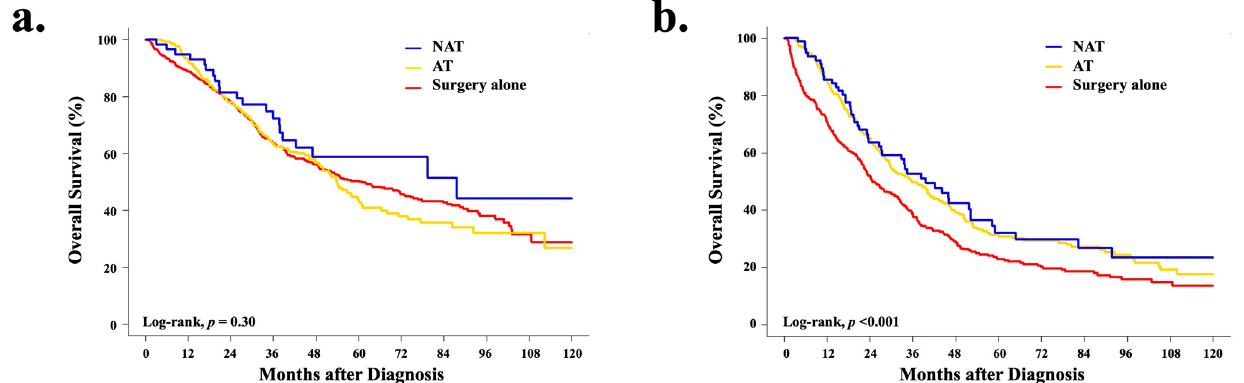
Figure 3. Unadjusted Kaplan–Meier curves for overall survival by treatment strategy for patients with ( a ) clinical stage I ( n = 1072) and ( b ) clinical stages II-III ( n = 760) resectable intrahepatic chol- angiocarcinoma.